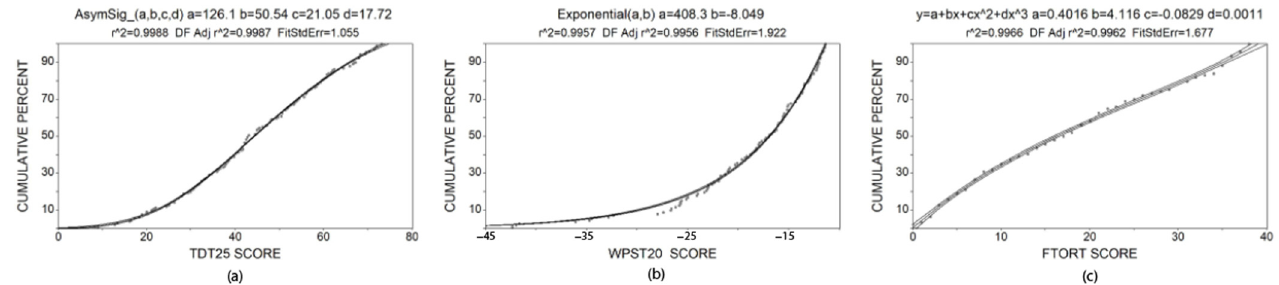
Figure 7. Cumulative distributions, fitted CDFs, and fit statistics for ( a ) TDT25 scores; ( b ) WPST20 scores; ( c ) fTORT scores. The fitted functions illustrate the difference in the rate of progression of percentile scores from 0% to 100%, with the TDT25 that conformed well to an asymmetric sigmoid function, in contrast to WPST20 percentiles progressing in line with an exponential function, while a cubic polynomial described well the fTORT progression. These CDFs reinforce the impression of dissimilar distribution shapes.